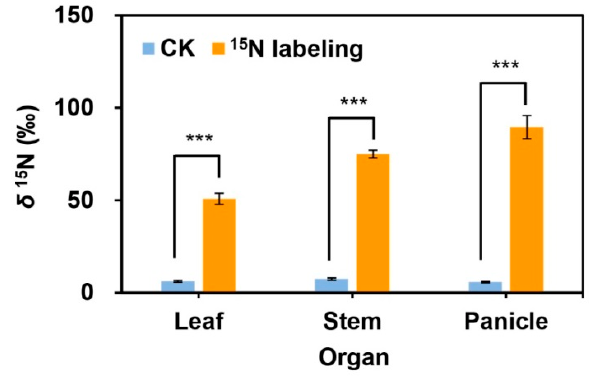
Figure 4. Comparison of the leaf δ 15 N, stem δ 15 N, and panicle δ 15 N of reproductive ramets between the control and 15 N labeling treatments in the natural populations of Hierochloe glabra (data are represented as the means ± standard errors, n = 5). ***, p <